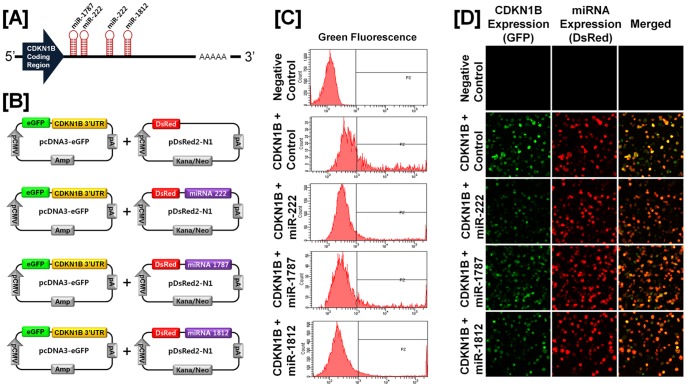

In vitro target assay for microRNAs in the CDKN1B transcript.[A] Diagram of miR-222, miR-1787 and miR-1812 binding sites in the 3′-UTR of the CDKN1Bgene. [B] Expression vector maps for eGFP within the 3′-UTR of the CDKN1B gene and Ds-Red within each miRNA. The 3′-UTR of the CDKN1B transcript was subcloned between the eGFP gene and the polyA tail to generate the fusion construct of the GFP transcript following the miRNA target 3′-UTR (pcDNA-eGFP-3′UTR) (upper panel) and the miRNA expression vector was designed to co-express DsRed and each miRNA (pcDNA-DsRed-miRNA) (lower panel). [C and D] After co-transfection of pcDNA-eGFP-3′UTR for the CDKN1B transcript and pcDNA-DsRed-miRNA for the miR-222, miR-1787 and miR-1812, the fluorescence signals of GFP and DsRed were detected using FACS [C] and fluorescent microscopy [D]. See Materials and Methods for complete description.